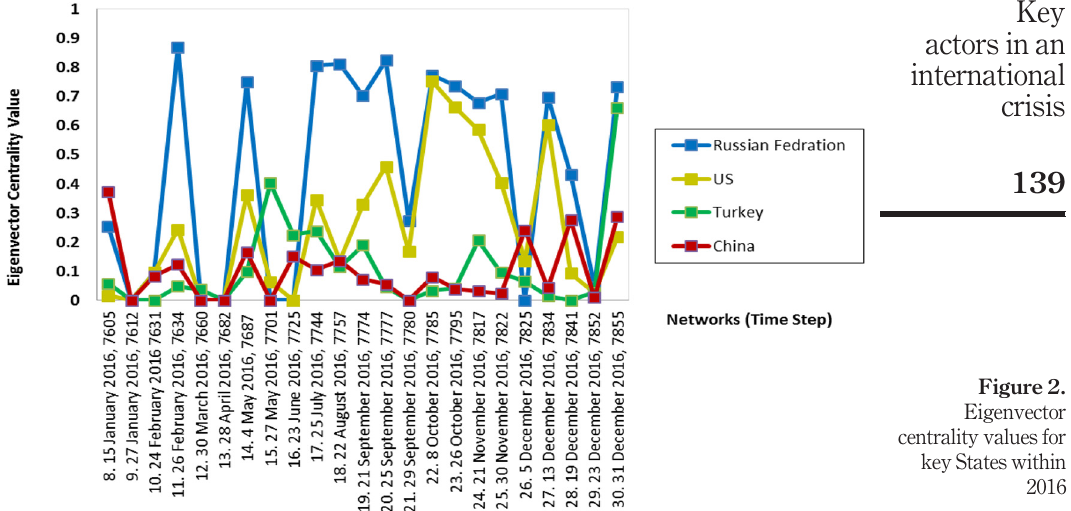
Figure 2. Eigenvector centrality values for key States within